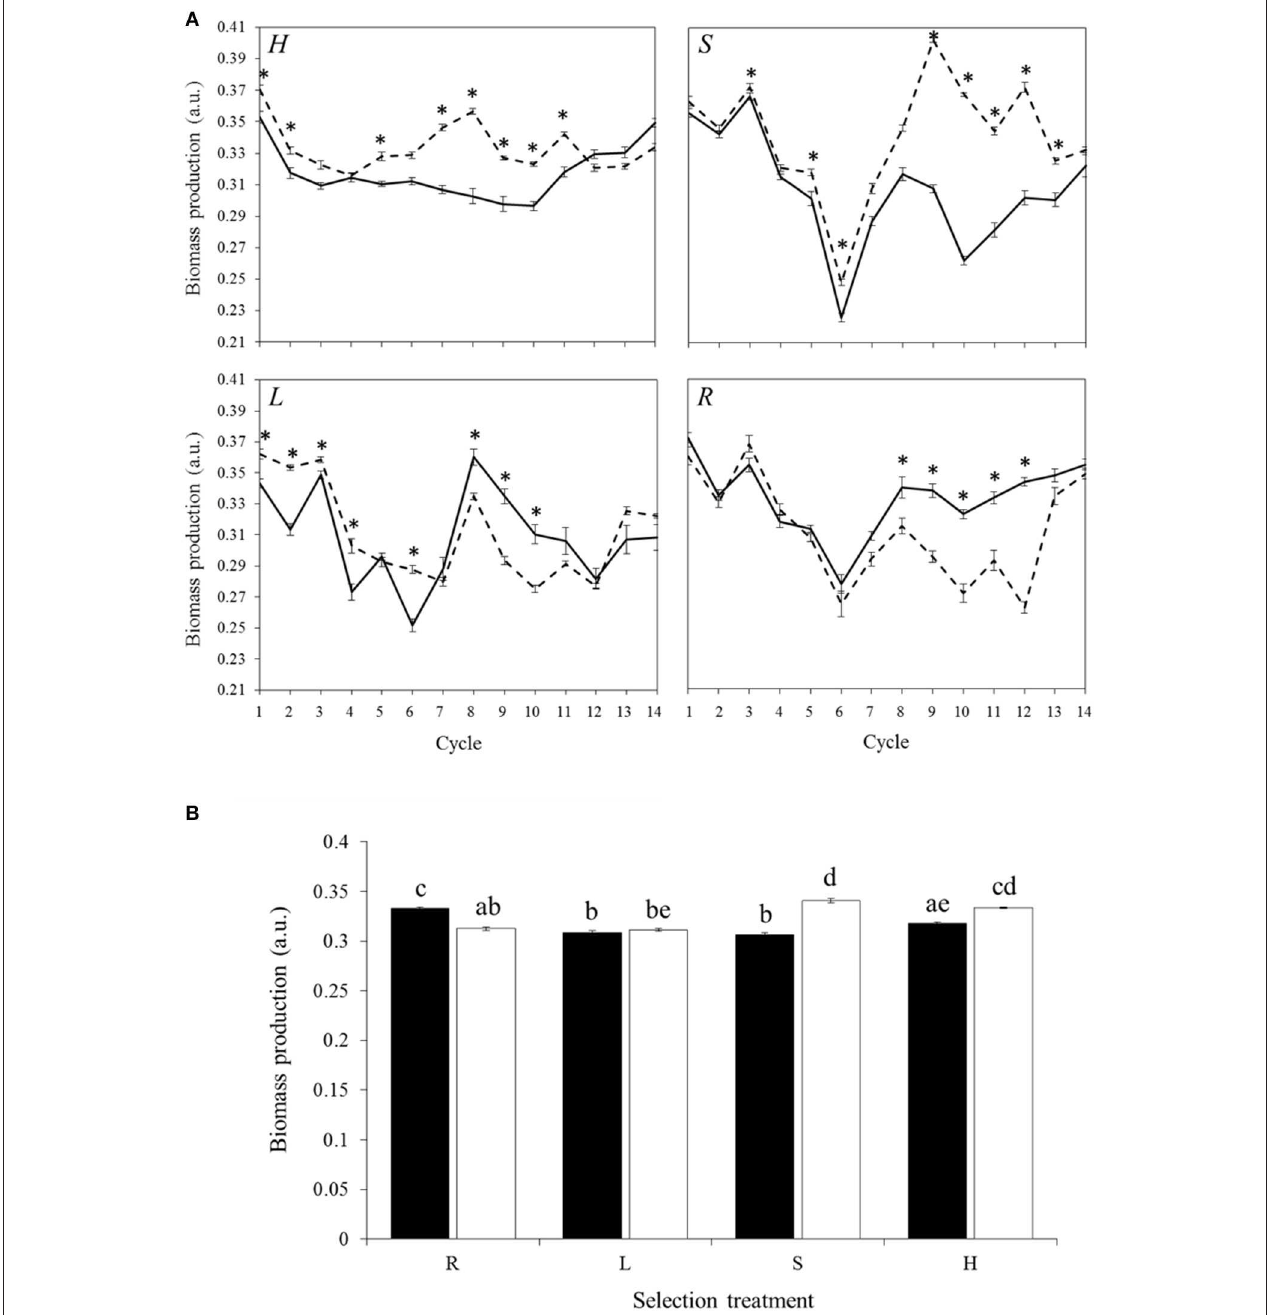
FIGURE 2 | Biomass production (A) Over time. Mean biomass production of the 30 communities of propagule (solid lines) or migrant pool (dotted lines) reproduction method. Biomass production of the communities from propagule lines was averaged even if these communities belonged to three distinct lines as their profile were quite similar. Bars represent SE. Asterisks represent significant differences between the two reproduction methods in a given cycle and selection treatment (Tukey HSD test at each cycle; p < 0.05). Top left, High; top right, Stabilizing; bottom left, Low; bottom right, Random. (B) All cycles together. Mean biomass production depending on the selection treatment and the reproduction method ( n = 420). Black, propagule; white, migrant pool. R, Random; L, Low; S, Stabilizing; H, High. Bars represent SE. Different letters represent significant differences (Tukey HSD test; p < 0.05).